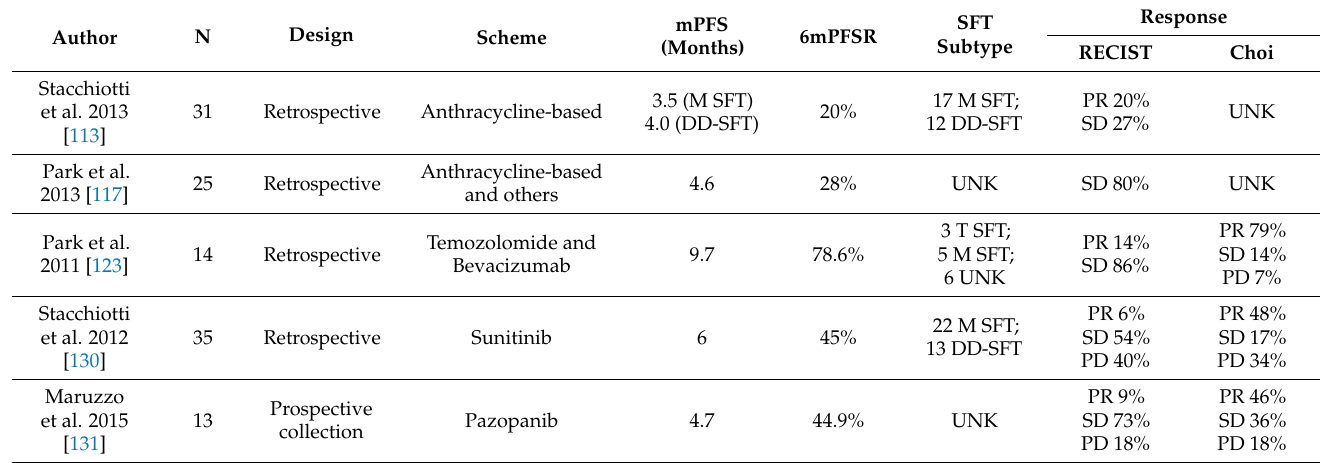
Table 4. Activity of antiangiogenics in solitary fibrous